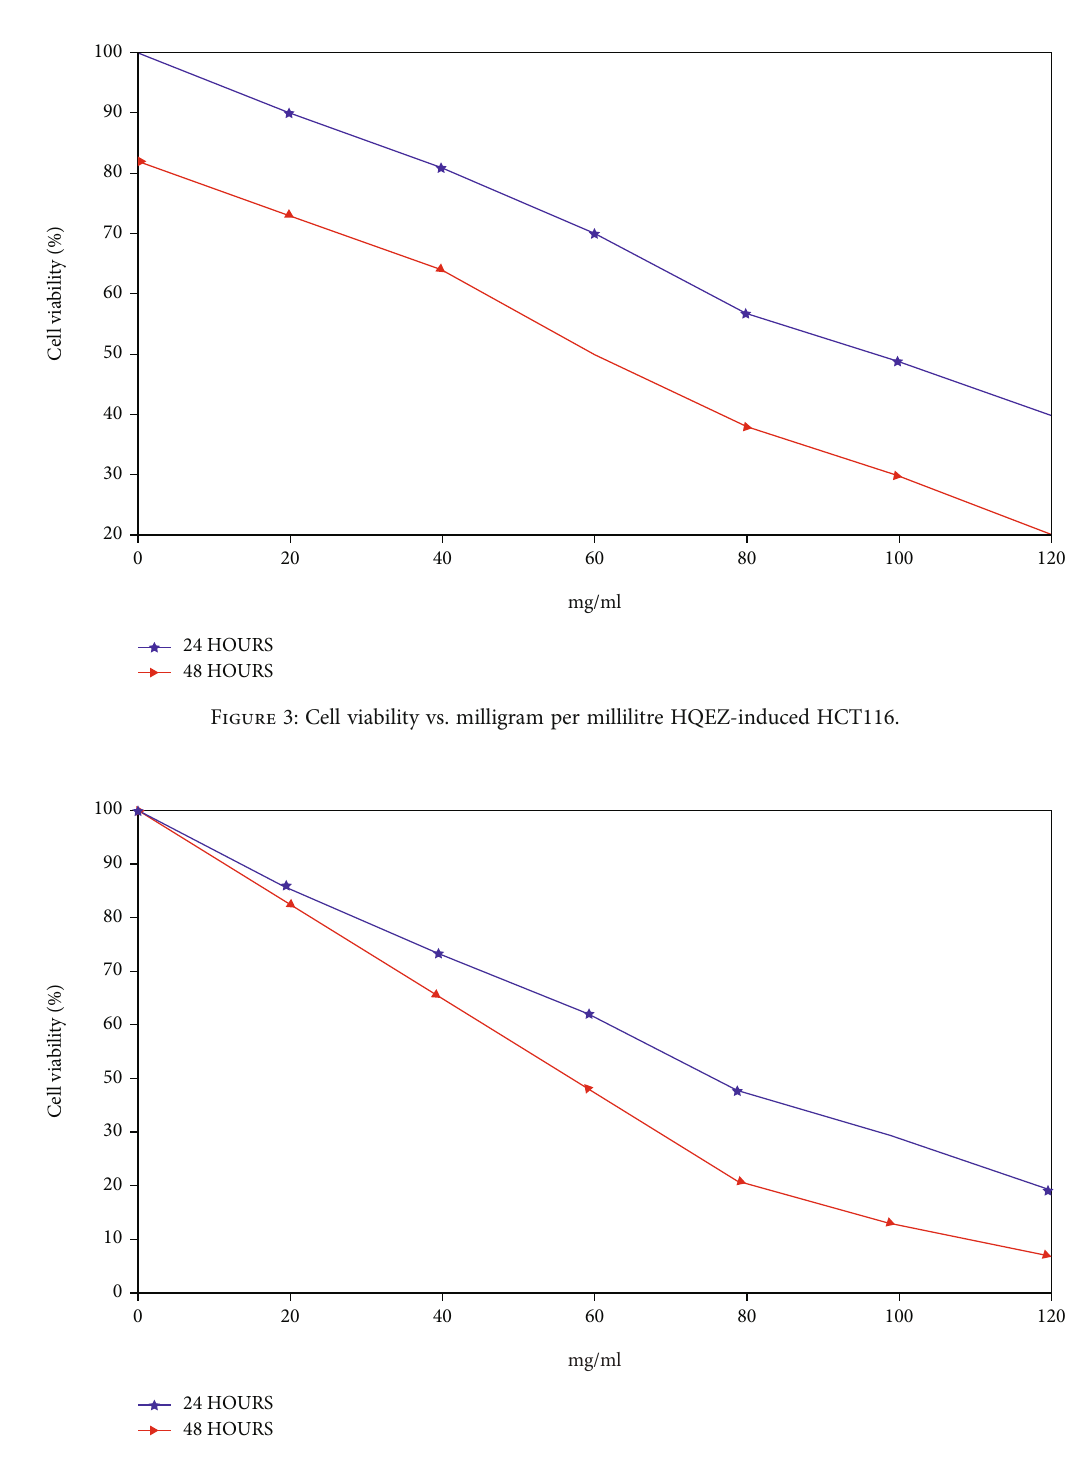
Figure 4: Cell viability vs. milligrams per millilitre.